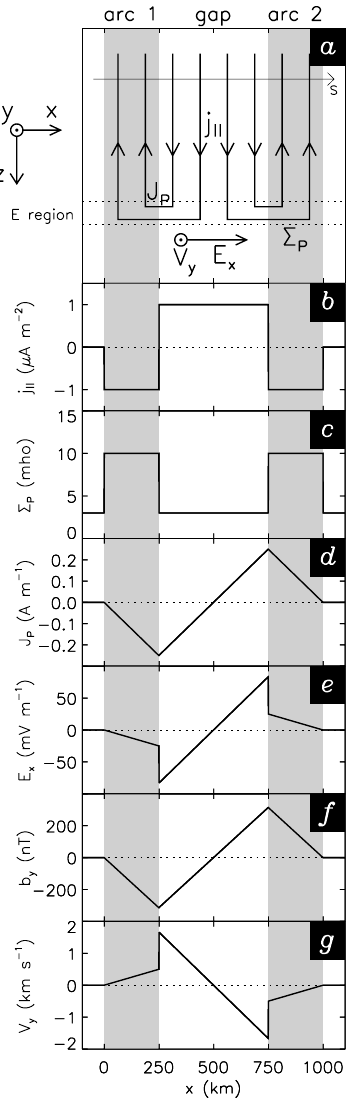
Fig. 4. A model of the expected field-aligned current (FAC) and electric field structure in the observed double-arc feature. ( a ) A schematic of the current flow in a coordinate system such that x points northwards along the magnetic meridian, y points eastwards, and z points vertically downwards along the magnetic field direc- tion. Grey bars indicate the location of upward FAC, associated with electron precipitation, and hence, auroral luminosity. ( b − g ) The latitudinal variation of field-aligned current density j k , Pedersen conductance 6 P , Pedersen current J P , electric field E x , the mag- netic perturbation experienced by a spacecraft S passing through the FAC system b y , and the ionospheric plasma drift V y